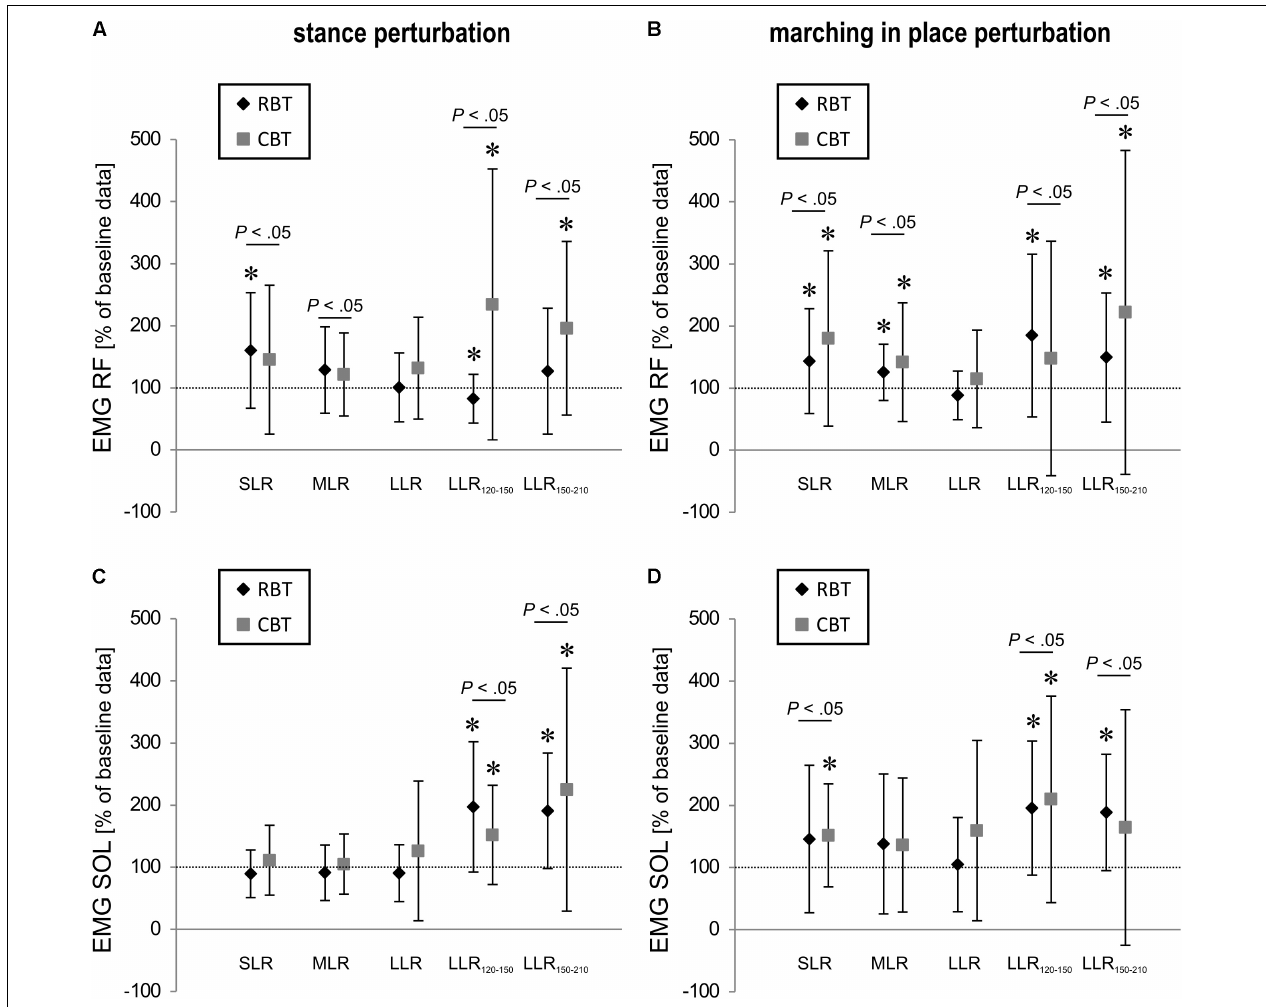
FIGURE 3 | Neuromuscular data of leg muscle activity. Changes of iEMG (in %) of the RF and soleus (SOL) muscles in the short- (SLR), medium- (MLR), LLR as well as 120–150 ms (LLR groups – the RBT group and the CBT group. Significant pre/post differences are marked with ∗ ( P t < 0.05), while significant time interactions are illustrated with bars ( P <